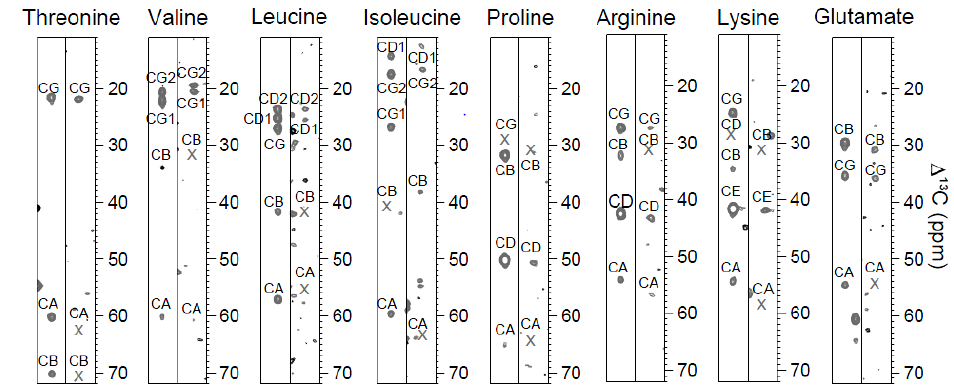
Figure 1. Amino acid type identification by the 3D CC(CO)NH experiment. The strips on the left and right side show spin systems of human ubiquitin and of hNaa50p, respectively. Even though CC(CO)NH is much less sensitive for larger proteins, a long mixing time allows for the observation of the remote carbons which are valuable for the assignment work. Crosses indicate chemical shifts that were determined from